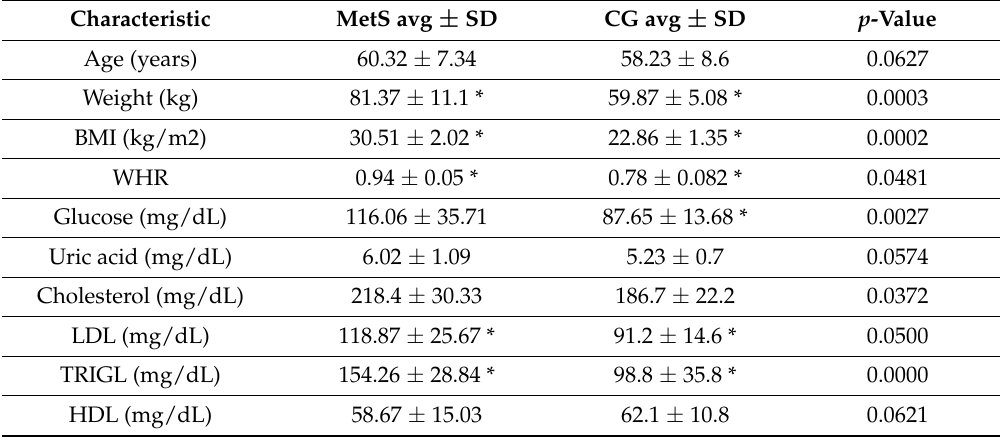
Table 6. Clinical and biochemical data of patients with metabolic syndrome (MetS) and the control group